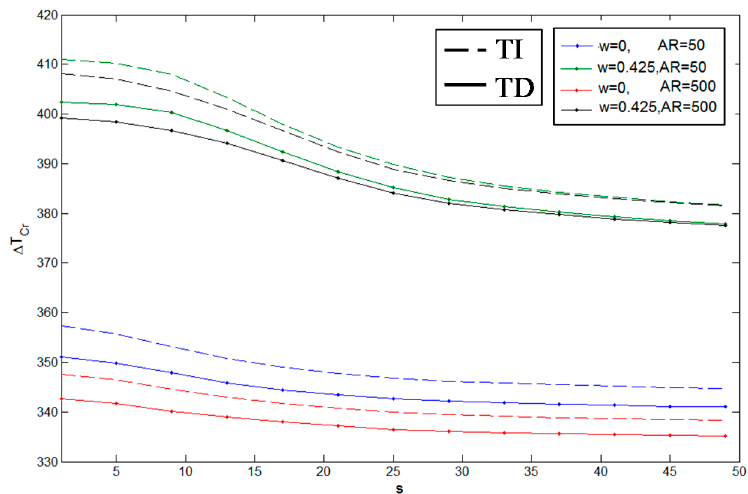
Figure 7. ∆ T cr vs. s for different combinations of aspect ratios A R and waviness indexes w considering = 0.28, N r = N s = L / R = 2, R / h = 200, V ∗ CNT